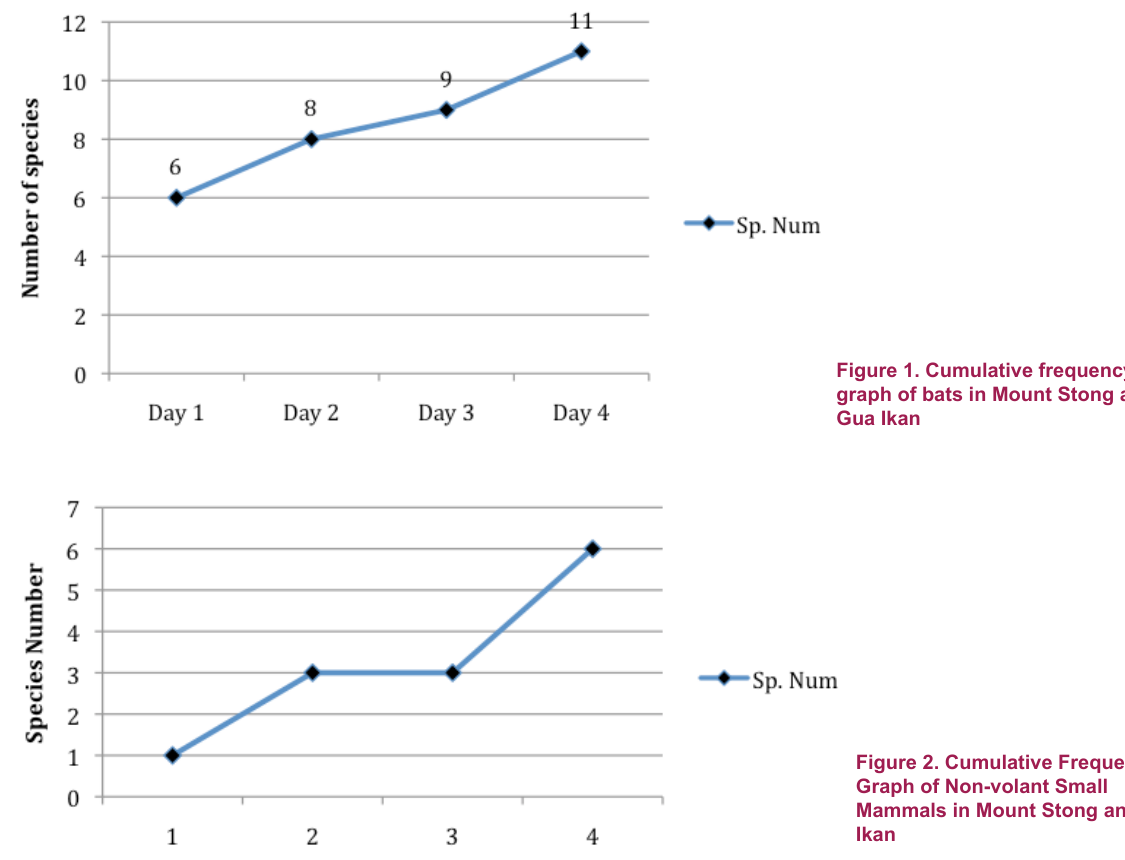
Figure 2. Cumulative Frequency Graph of Non-volant Small Mammals in Mount Stong and Gua